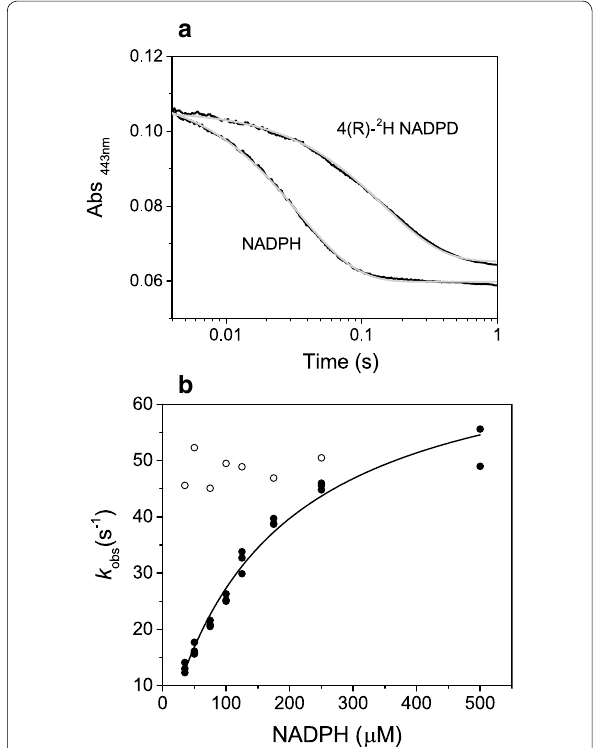
Fig. 6 Single-wavelength stopped-flow experiments. a Stopped-flow single wavelength absorbance (443 nm) after mixing 20 μM of GSTACMO with 200 μM of NADPH or 4( R )-[4- 2 H]NADPH. Absorbance traces (black lines) were collected over 1 s ( a ) and fitted to standard single exponential equation (grey dotted line), which gave values of k red1 of 28.4 0.5 s − 1 (NADPH) and 7.5 0.2 s − 1 (4( R )-[4- 2 H]NADPH). ± ± b Dependence of k red1 on the concentration of NADPH of wild type ACMO (solid circles) and the H325K variant (open circles). The data were fitted to Eq. 6 and the results are shown in Table